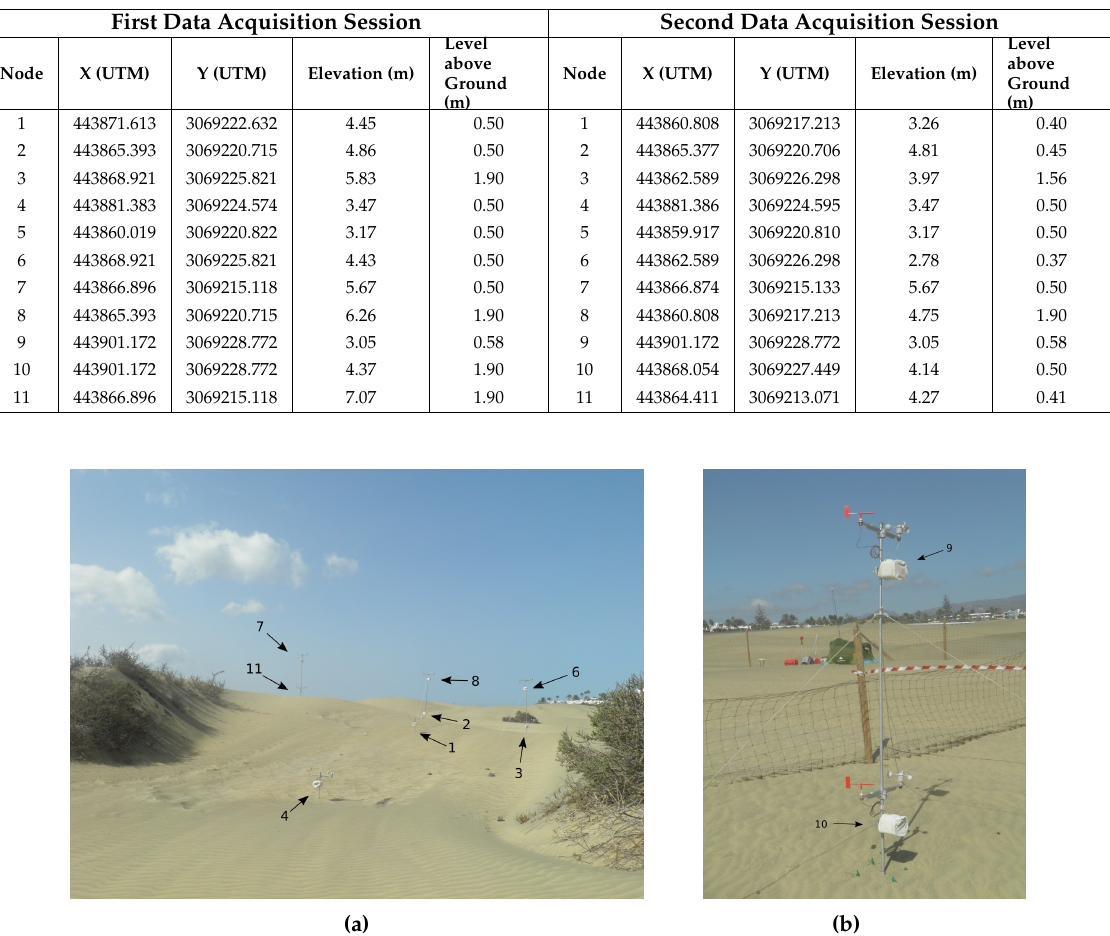
Figure 12. Photographs of the deployed devices at the experimental site during the first data acquisition session. Following the geographical layout depicted in Figure 11a, the left-hand image, ( a ), shows on either side the Traganum moquinii specimens at the two extremes of the dune, as well as eight of the eleven devices which were deployed, namely devices 1, 2, 3, 4, 6, 7, 8, and 11. Device 5 is occluded behind the dune and does not appear in the image. In the image on the right-hand side, ( b ), the last two devices, 9 and 10, are